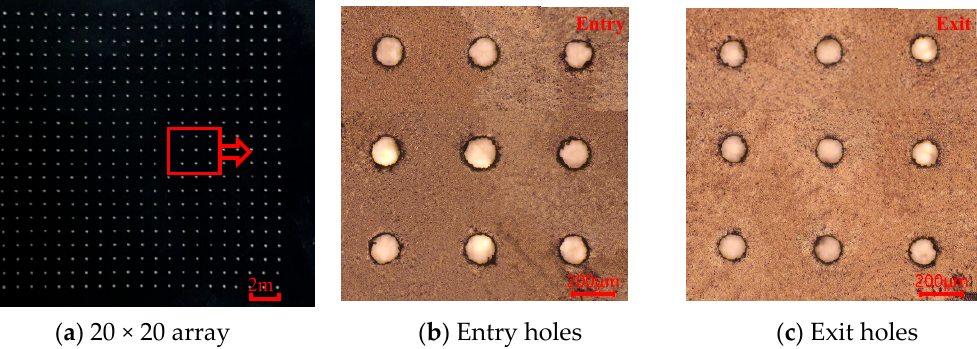
Figure 10. Microscope image of microholes on PDMS generated at laser scanning speed of 1000 mm/s and the pulse energy of 12 µ J; ( a ) 20 × 20 array of microholes; ( b ) 3 × 3 array of entry holes; ( c ) 3 × 3 array of exit